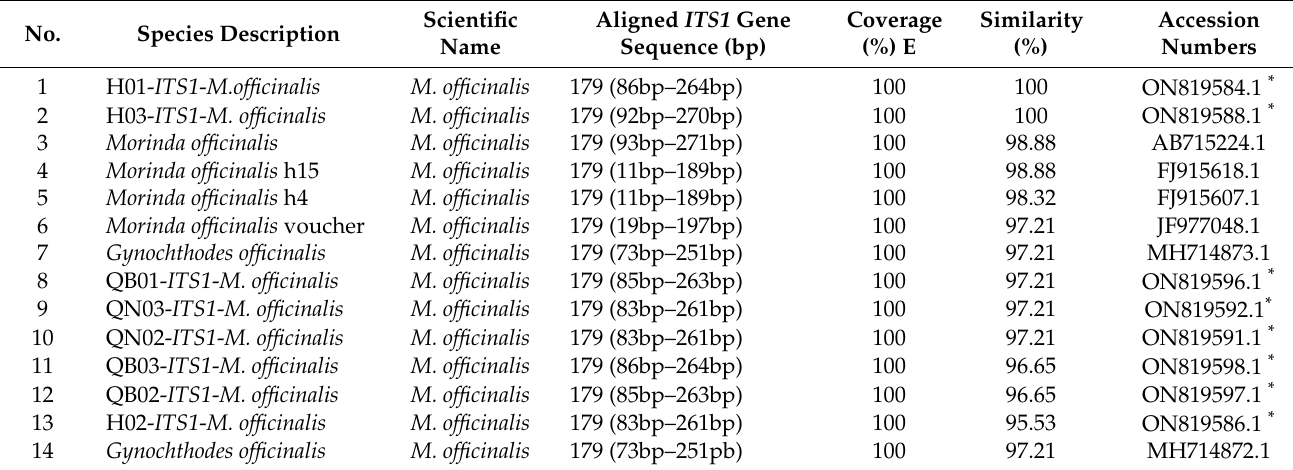
Table 3. M. officinalis plants in this study and the percentage of similarity to the closest species in the GenBank as per ITS1 gene sequence.